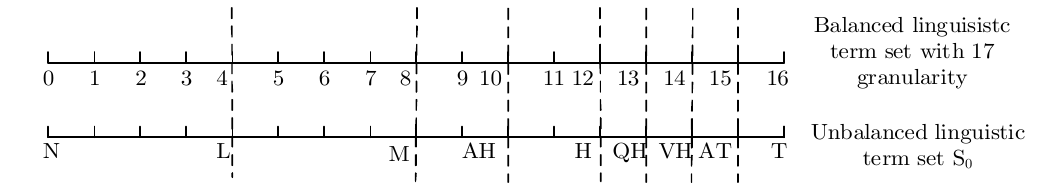
Figure 1. Unbalanced linguistic term set S 0 and its mapping in linguistic hierarchy.